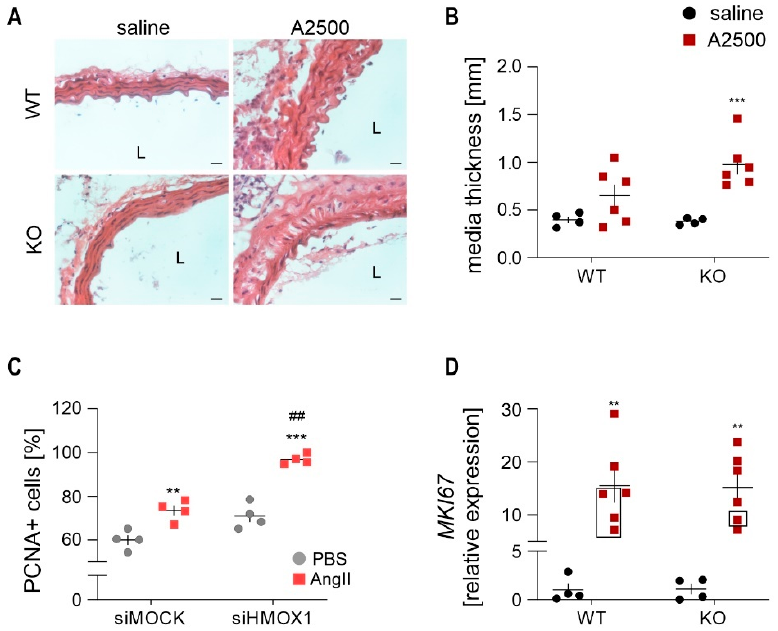
Figure 7. AngII infusion to HO-1 knockout mice triggers significant thickening of media. The mice were infused with either saline or angiotensin II at the dose 2500 ng/kg/min using the osmotic pumps for 14 days. ( A ) Haematoxylin and eosin staining of aortas. Representative images; magnification 400 × ; scale bar = 50 µ m; ( B ) Quantification of media layer thickness of abdominal aortas; Two-way ANOVA with Tukey’s post hoc test. *** p < 0.001 vs. saline; ( C ) Percentage of proliferating human aortic smooth muscle cells in response to 24 h stimulation with 50 nM AngII. Number of proliferating cells was assessed by PCNA—proliferating cells nuclear antigen staining; Two-way ANOVA with Tukey’s post hoc test. *** p < 0.001 vs. PBS, ## p < 0.01 vs. siMock; ( D ) Relative expression of proliferation marker MKI67 in the abdominal aortic wall. eEF2 was used as a reference gene. Two-way ANOVA with Tukey’s post hoc test, ** p < 0.05 vs. saline; rectangle—mice which developed the aneurysm.